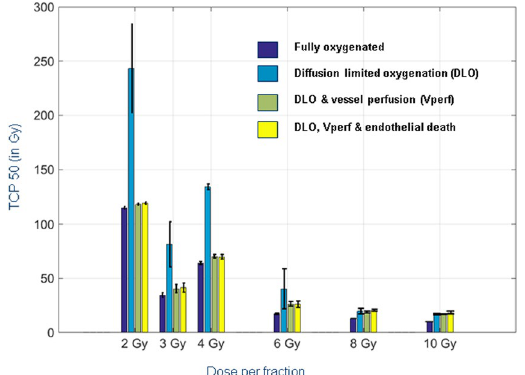
Figure 7. Visualizing the impact of various vessel damage models on TCP50. Each panel compares the total dose (Gy) required to reach the TCP50 for each given protocols (see Fig.